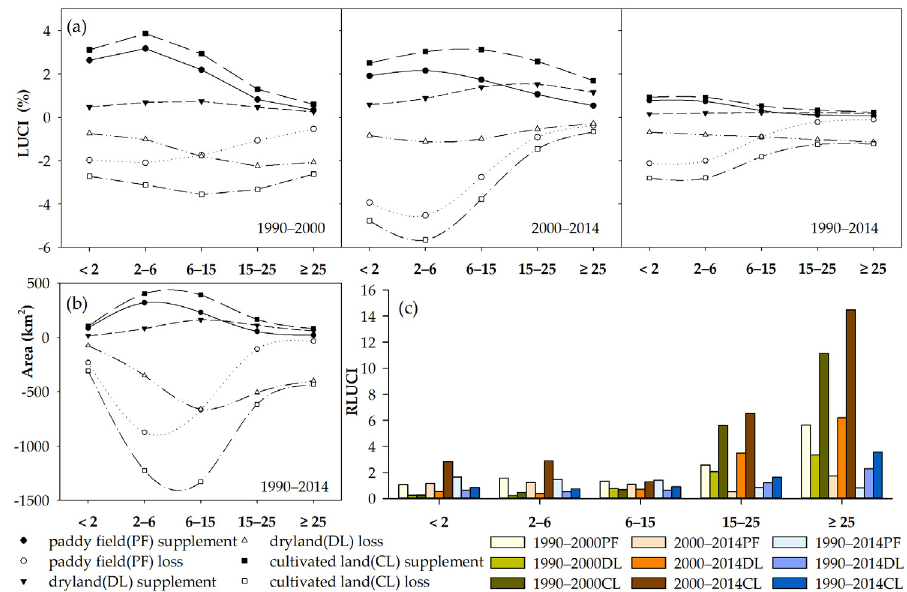
Figure 5. Changes in cultivated land at different slope levels. ( a ) The variation in land-use change intensity at different slopes in different periods, ( b ) the change of area in cultivated land at different slopes during 1990–2014, ( c ) the ratio of cultivated land change at different slopes compared to that in the whole Hunan province.